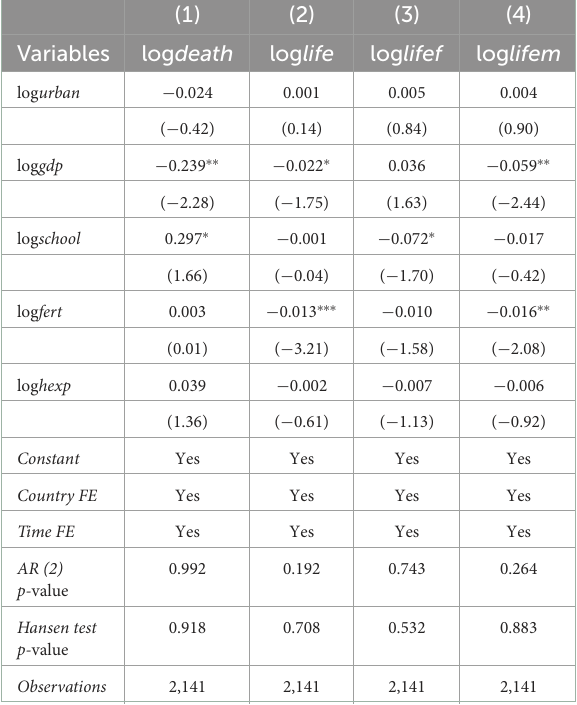
TABLE 6 System GMM estimation